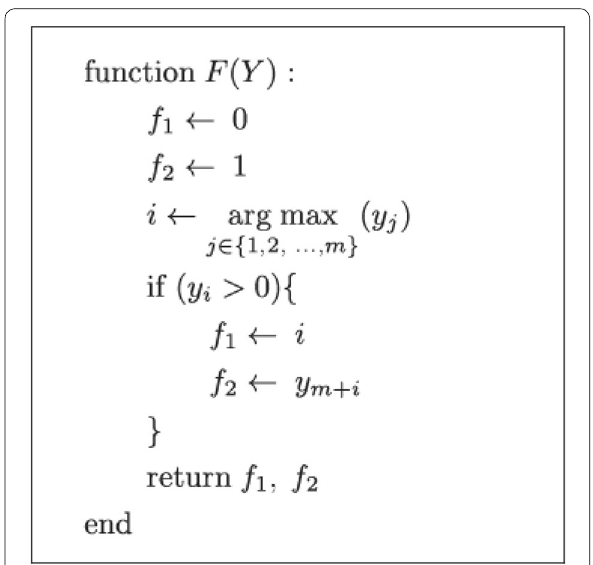
Fig. 11 Pseudo code of the fault detection and isolation, and magnitude